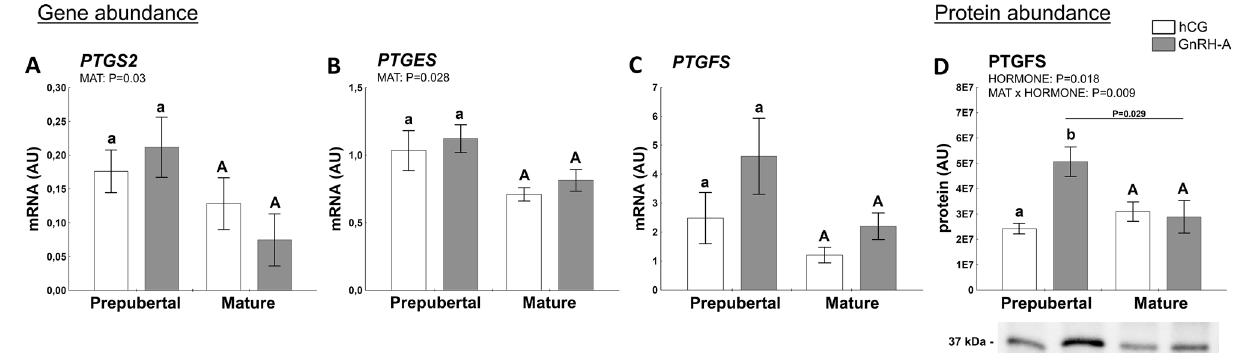
Figure 3. Hormones (hCG and GnRH-A) and sexual maturity status (prepuberty or maturity; MAT) affect abundance of factors involved in prostaglandin synthesis in ovarian follicles of prepubertal and mature gilts. The abundance of PTGS2 mRNA ( A ), PTGES mRNA ( B ), and PTGFS mRNA/protein ( C , D ) in prepubertal and mature gilts was evaluated. Gene expression was normalized to the geometric mean of ACTB and GAPDH, identified as the best reference genes by NormFinder algorithm. Protein levels were normalized to total protein content using TGX Stain-Free gel technology ( D ). Uncropped blots are presented in Supplementary Fig. 3B online. Data were analyzed using two-way ANOVA with Sidak multiple comparison (mRNA) or Tukey (protein) post-hoc tests and are presented as mean ± SEM (n = 5–6 per group). Means with different superscripts differ significantly (small letters—prepubertal gilts, capital letters—mature gilts; P < 0.05). Line with a P value denote significant differences between prepubertal and mature